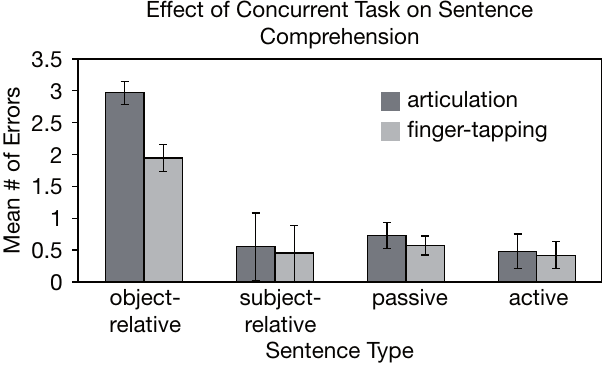
Figure 2 | Mean comprehension performance as a function of sentence type and concurrent task. Note that during each concurrent task, 10 of each sentence type were presented. Error bars represent 95% confi dence intervals. Table 1 | Summary of paired sample t -tests comparing object-relative sentence comprehension with that of the other three sentence types during articulation and fi nger-tapping task,